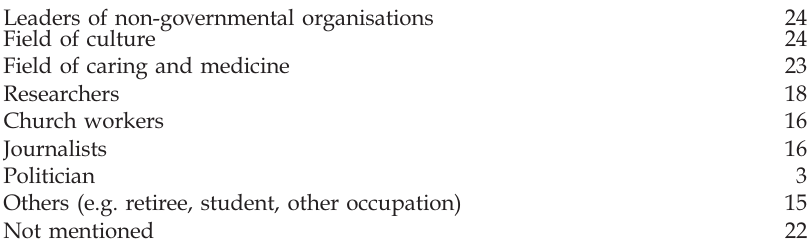
Table 2. Amount of writers and main inter v iewees in the texts by separate occupational groups ( N (cid:3)